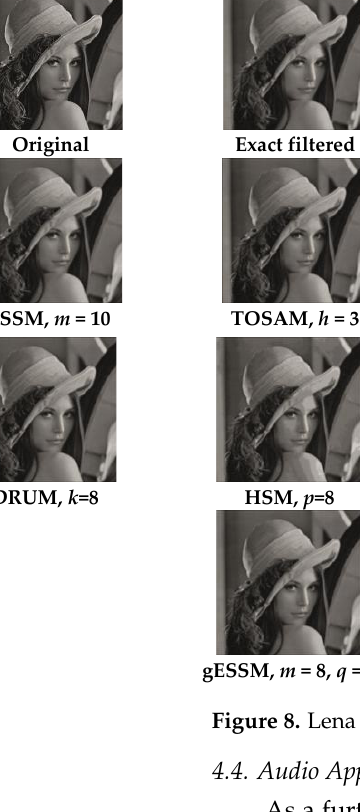
Figure 8. Lena image filtered by means of segmented multipliers.